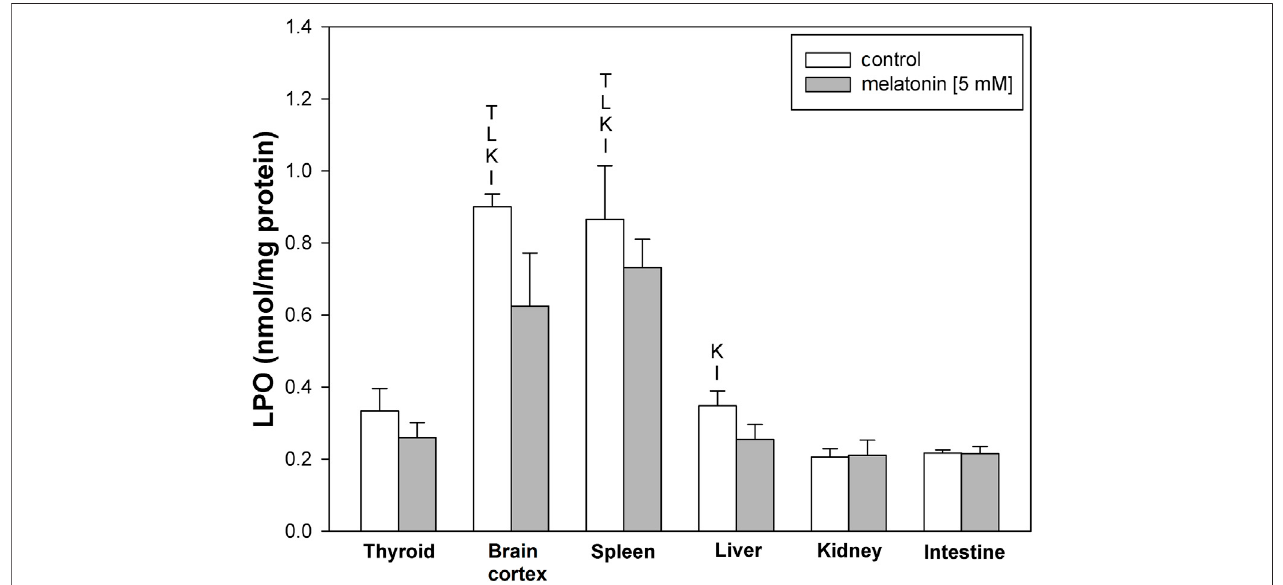
FIGURE 1 | Concentrations of lipid peroxidation products (MDA+4-HDA) in the homogenates of porcine tissues (thyroid, brain cortex, spleen, liver, kidney, and intestine) incubated without any substance (control; white bars) or with melatonin (5 mM) (gray bars). T – p < 0.05 vs. respective control in the thyroid; L – p < 0.05 vs. respective control in the liver; K – p < 0.05 vs. respective control in the kidney; I – p < 0.05 vs. respective control in the intestine. Differences in LPO levels between control and melatonin are not statistically signi fi cant in particular tissues. Statistical differences between particular tissues after melatonin exposure are not